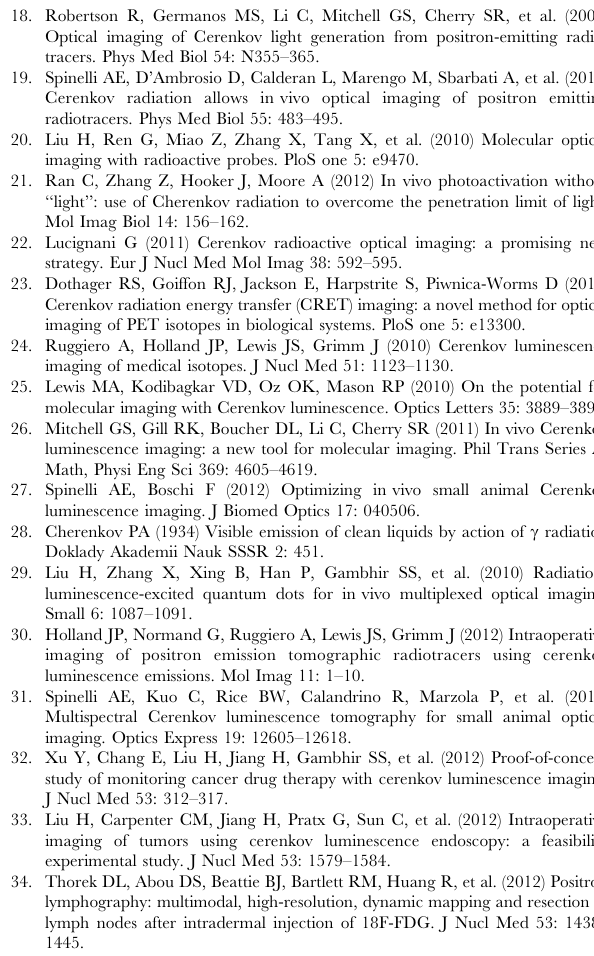
Figure S1 Representative CLI images of dissected tissues (n= 3). 1) liver, 2) heart, 3) lung, 4) brain, 5) muscle, 6) kidney, 7) spleen, 8) intestine, 9) bladder, 10) skin, 11) blood, 12) stomach, 13) white fat from belly, 14) BAT. (TIF) Figure S2 Quantitative analysis of signals of the NE- treated group and the control group. Radioactivity reading (a), in vivo CLI signals (b), and ex vivo CLI signals (c) (n= 4 for each group). (TIF) Figure S3 Raw images for spectral unmixing and multispectral Cerenkov luminescence tomography im- aging.